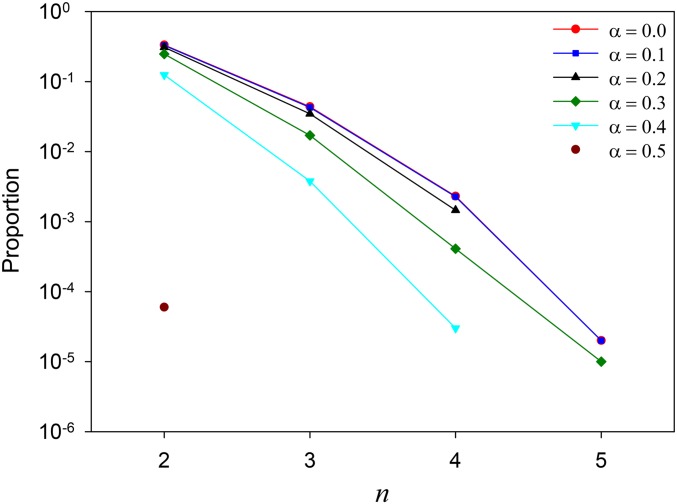
Parameter/state space maintaining all n alleles. The red line with filled circles shows the potential for polymorphism with α = 0 (as in Lewontin et al. 1978); α = 0.1: dark blue line with squares; α = 0.2: black line with upright triangles. α = 0.3: green line with diamonds. α = 0.4: light blue line with upside-down triangles. α = 0.5: purple circle.